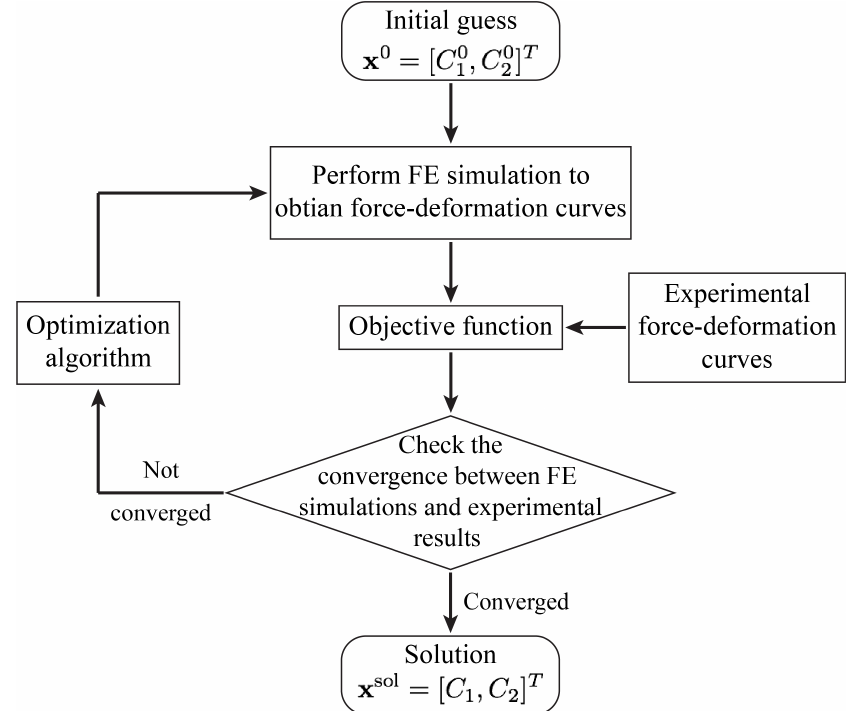
Figure 7. A flowchart of inverse FE optimization used in estimating the Mooney-Rivlin material